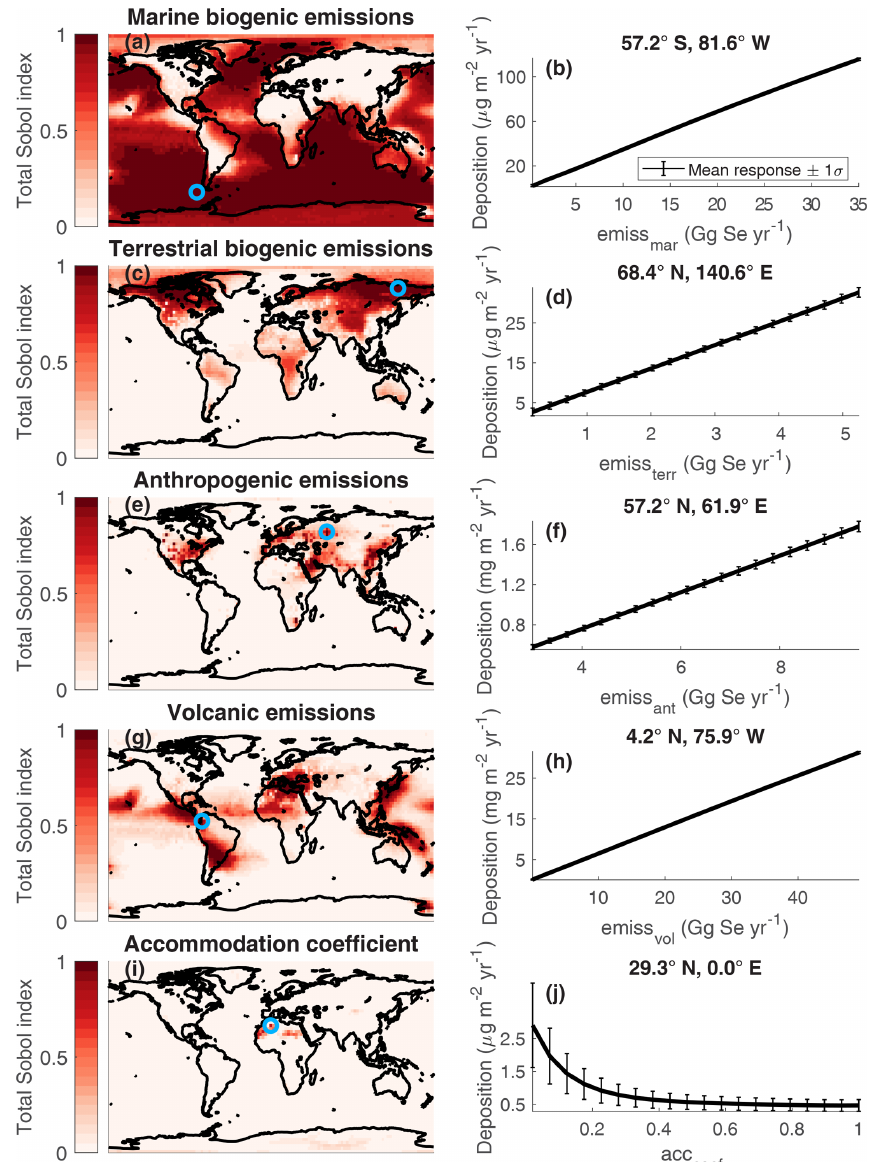
Figure 9. Maps of the total Sobol’ indices of emission parameters and the accommodation coefficient for total Se deposition (left column). A blue circle indicates the grid box where the total Sobol’ index is at a maximum. The relationship between total Se deposition and the input parameters in that grid box, calculated by resampling the surrogate model for deposition, are shown (right column). Note that the magnitude of deposition ( y axis) varies in each plot, depending on the grid box